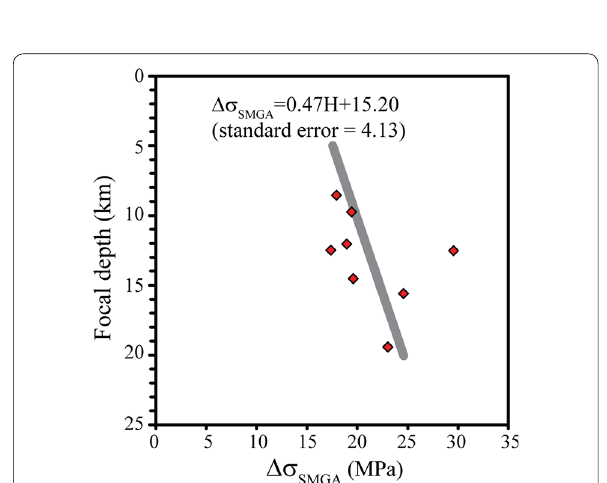
Fig. 6 Relationship of focal depth versus stress drop on SMGA. The diamonds indicate events examined in this study. The gray line repre‑ sents the empirical relationship obtained in this